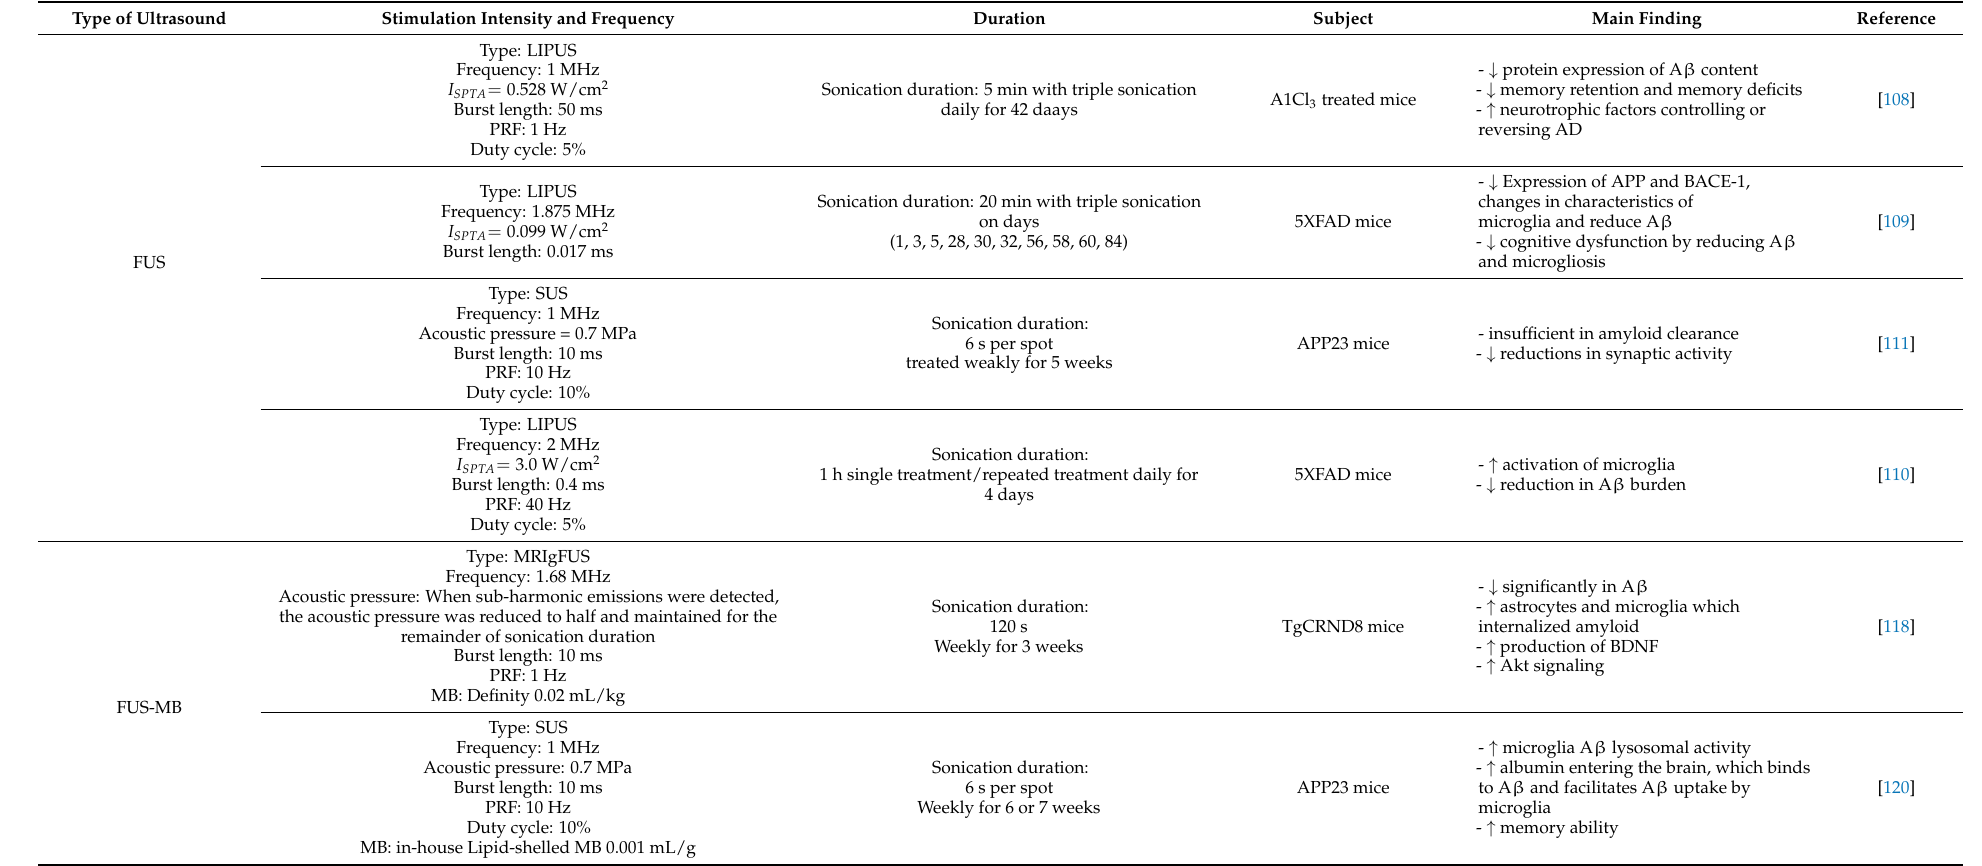
Table 5. A summary of ultrasound on A β and tau